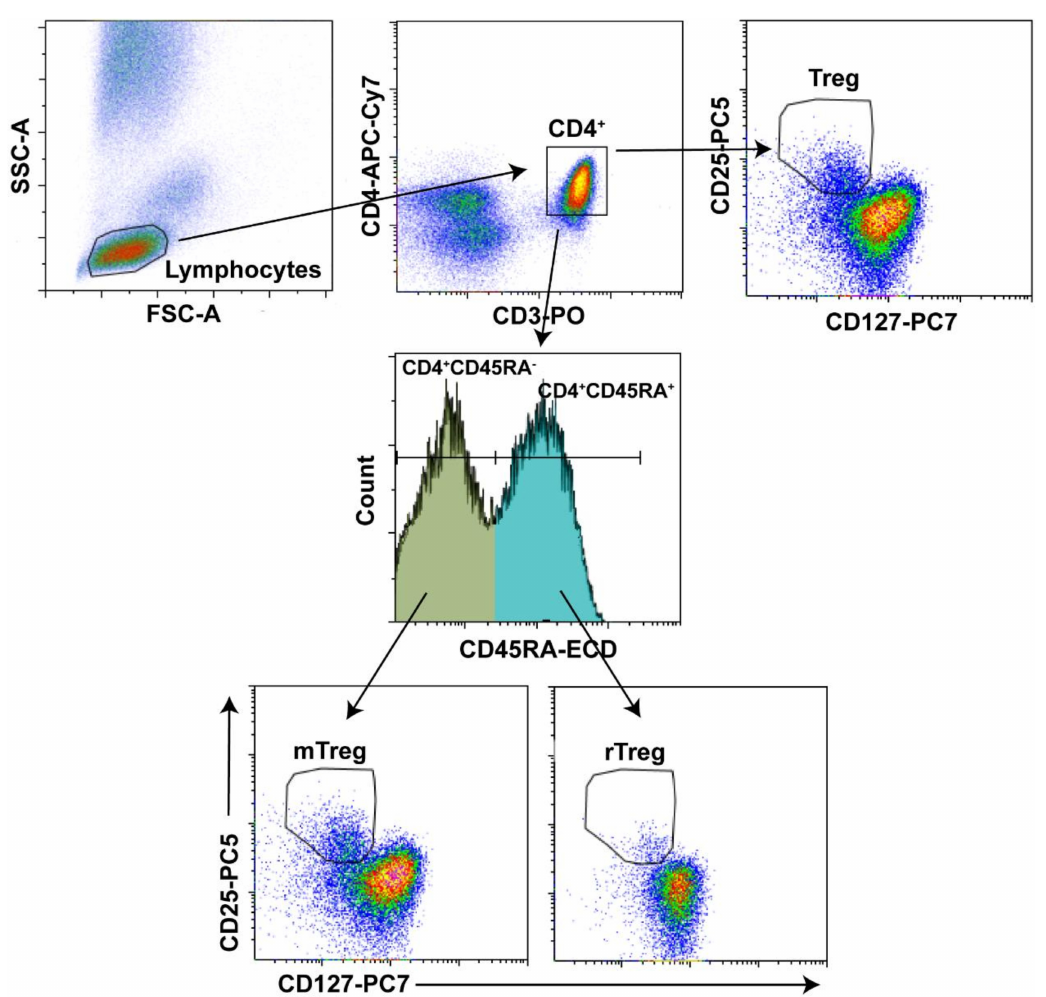
Figure 1. Flow cytometry gating strategy for regulatory T cells subsets. Representative sample of gating strategy used to evaluate the frequency of regulatory T cells subsets is shown. Lymphocytes were first gated on a forward scatter/side scatter (FSC-A/SSC-A) dot plot. The lymphocytes events were visualized using a CD3/CD4 dot plot and the CD4 + T cells were gated on a gate CD4 + . Cells on CD4 + are simultaneously displayed on both the CD127/CD25 dot plot and CD45RA histogram. CD127 low/ − CD25 + cells appear in gate Treg and subsets CD4 + CD45RA − and CD4 + CD45RA + were gated on CD127/CD25 dot plot to visualize mTreg and rTreg cells,